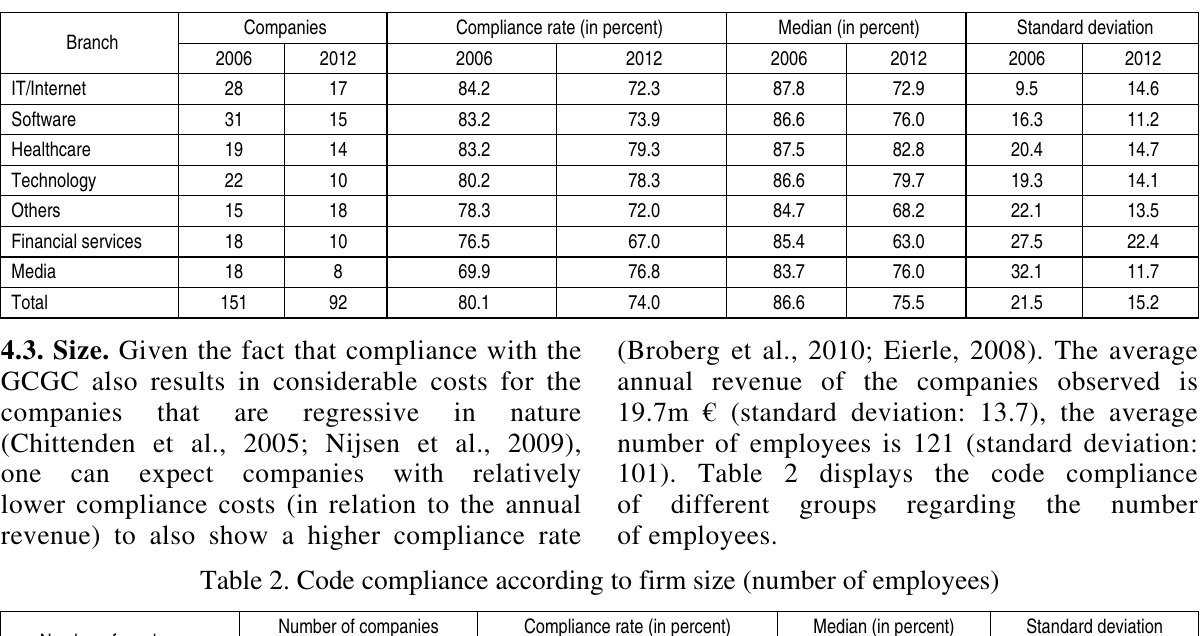
Table 1. Code compliance in different branches